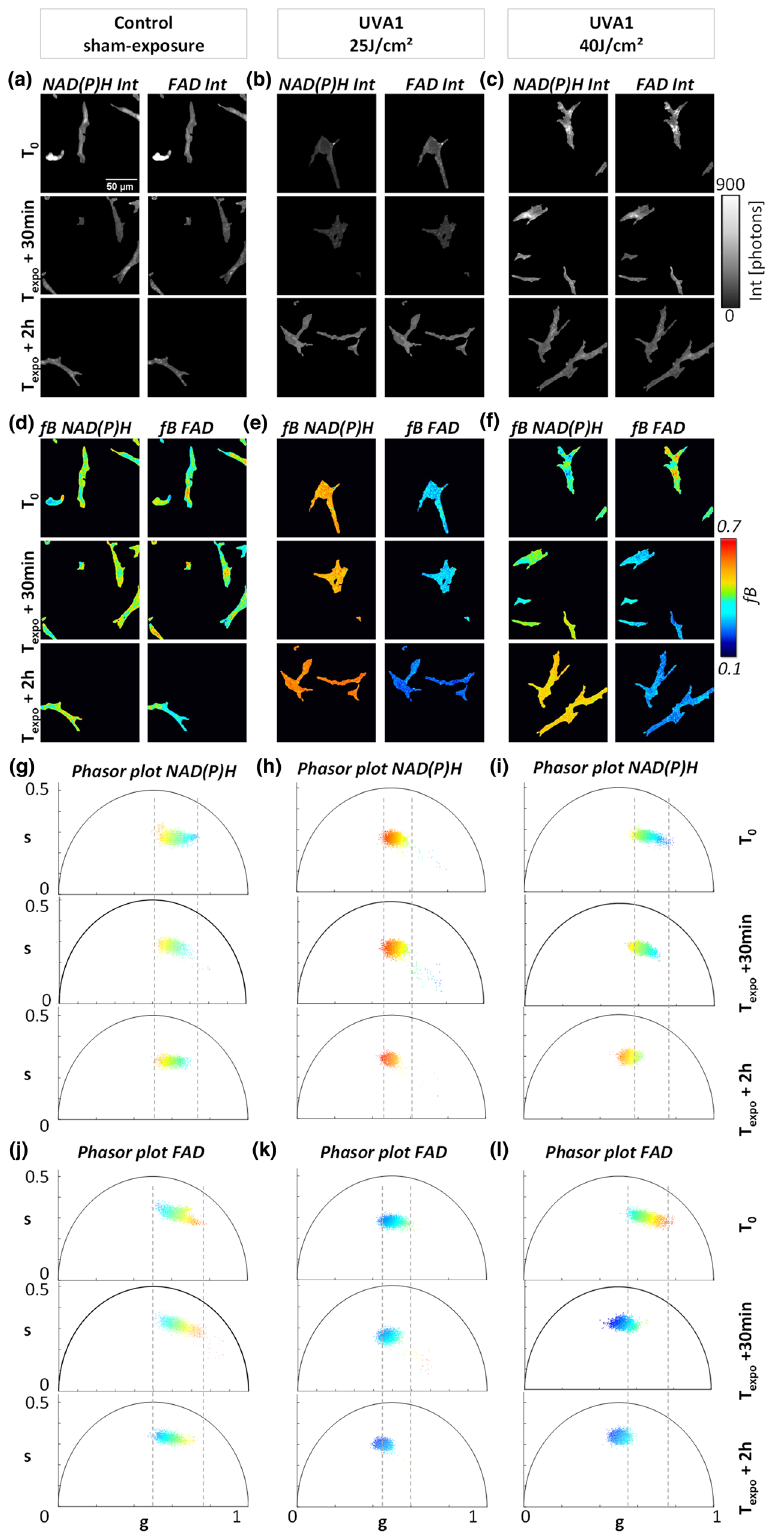
Figure 4. Temporal dynamic of UVA1 dose effects on NAD(P)H and FAD metabolic biomarkers in superficial dermis fibroblasts of reconstructed human skin. Representative images of ( a – c ) NAD(P)H and FAD fluorescence intensities and ( d – f ) f B fractions of bound NAD(P)H and FAD before (T 0 ), at 30 min (T expo + 30 min) and 2 h (T expo + 2 h) post sham-exposure (Control) or UVA1 exposure at 25 J/cm 2 and 40 J/cm 2 . ( g – i ) Representative phasor plot scatters of NAD(P)H and ( j – l ) FAD fluorescence lifetime data of the same samples at T 0 , T expo + 30 min and T expo + 2 h. Every pixel of the phasor plot is color coded according to the fraction of bound metabolites with the same look up table as for images ( d )–( f